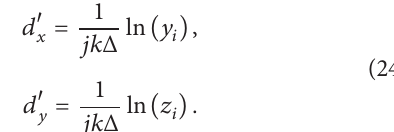
Figure 3: The cross-section of the pattern.